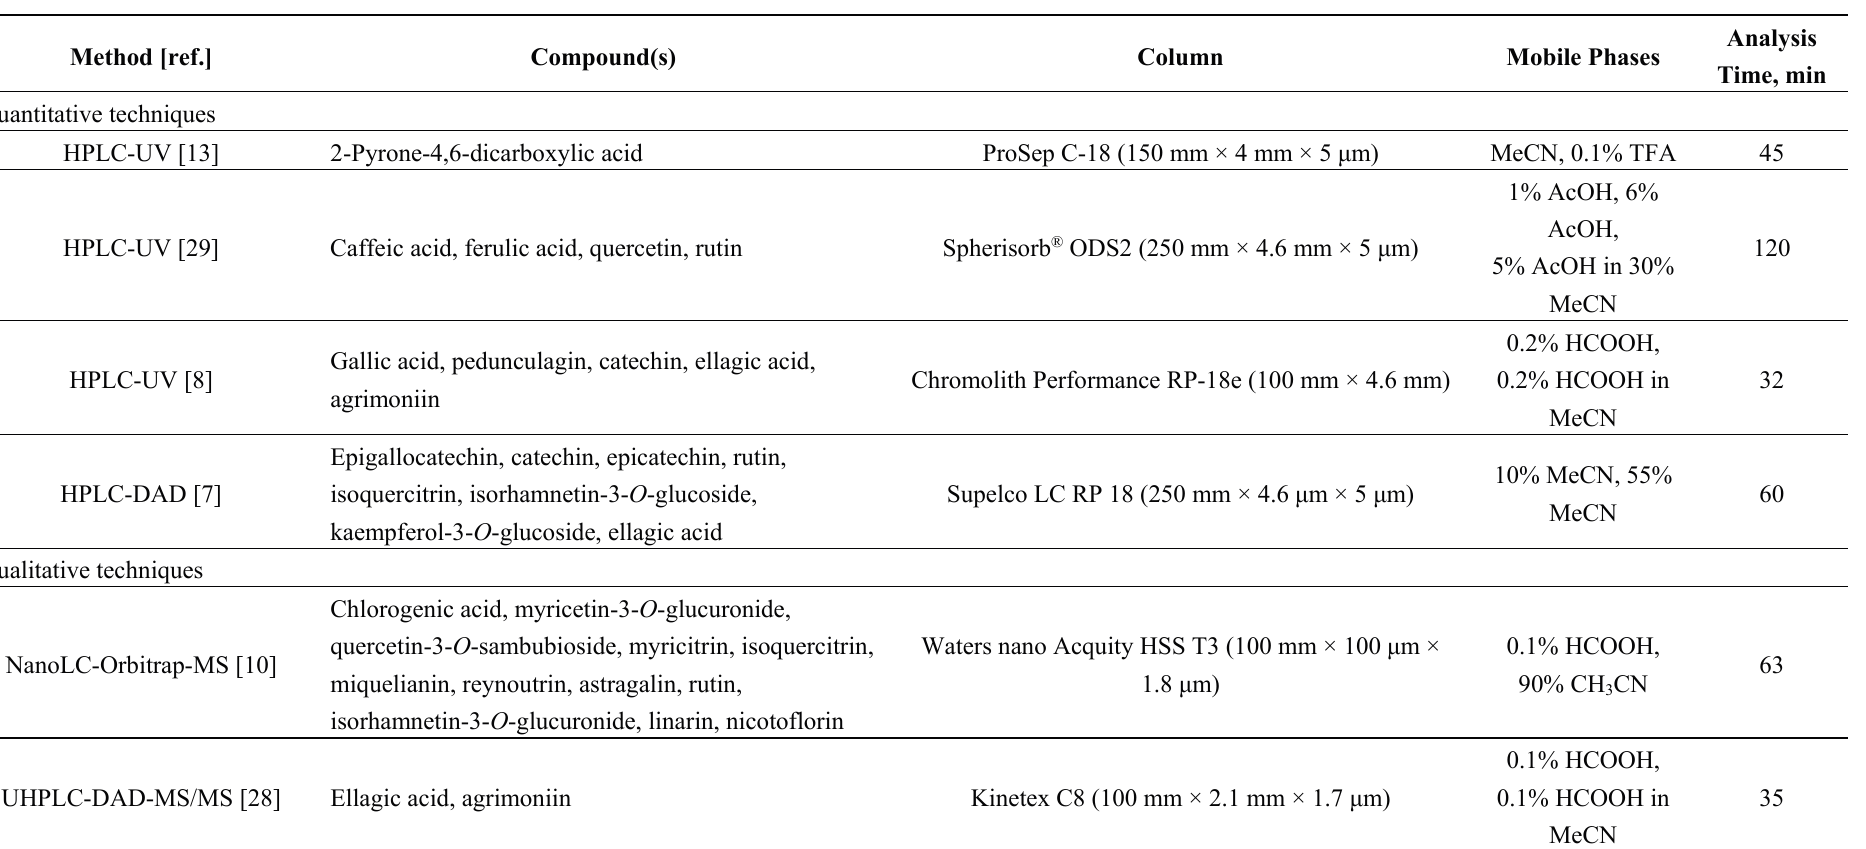
Table 1. Known HPLC assays for analysis of P. anserina